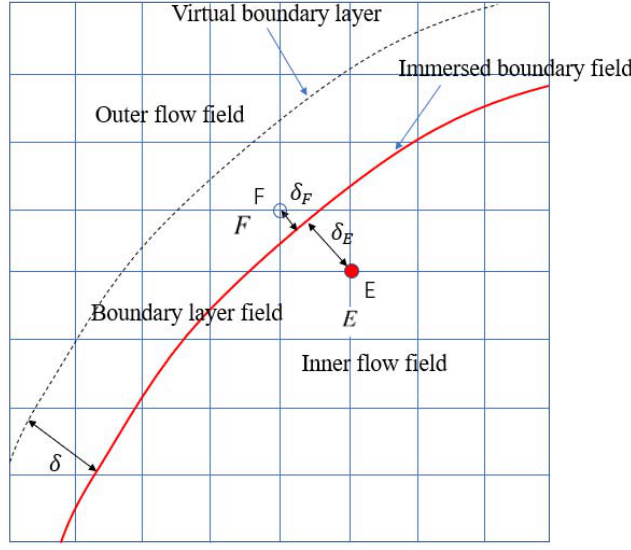
Figure 1. Schematic diagram of virtual boundary layer.